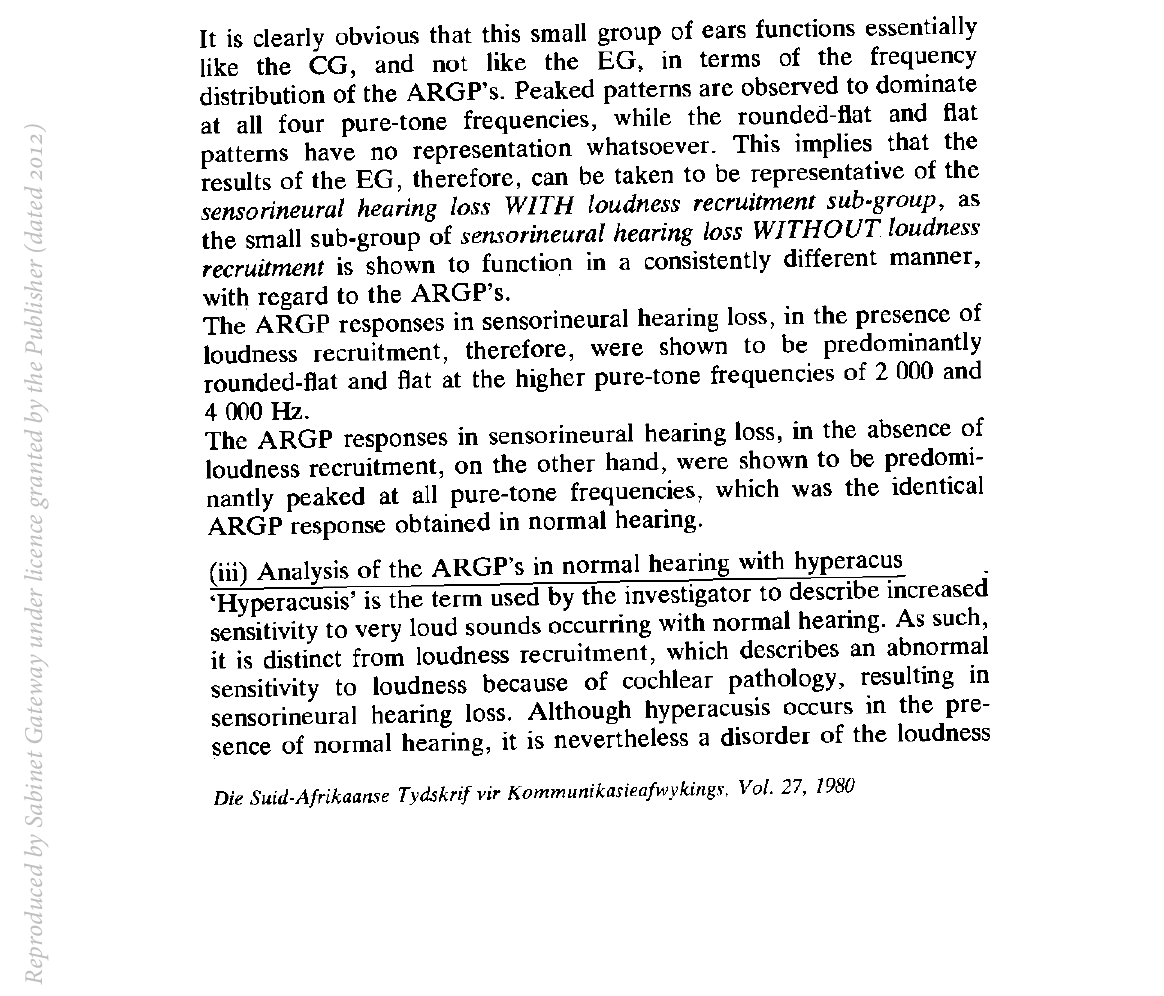
TABLE VI: Frequency Distribution of the ARGP's at each Pure-Tone Frequency in EG, without Loudness Recruitment (5 Ears) Frequency of Occurrence at: ARGP ARGP 500 Hz 1 000 Hz 2 000 Hz 4 000 Hz Total 5 Peaked Rounded P/Rounded Flat R/Flat